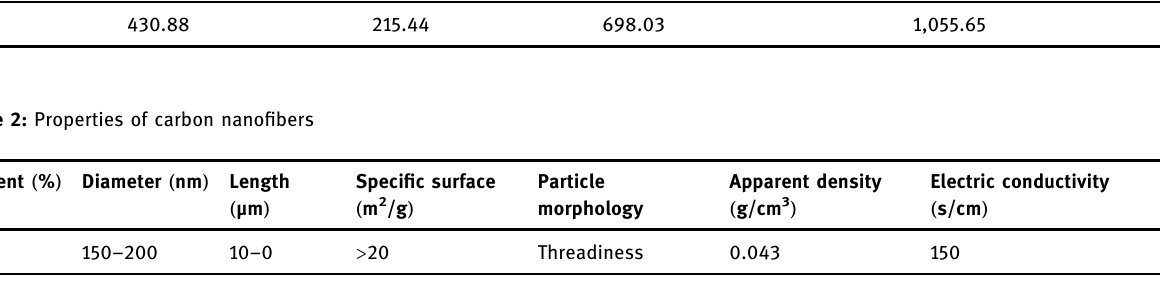
Table 1: Basic mix proportion of concrete Number